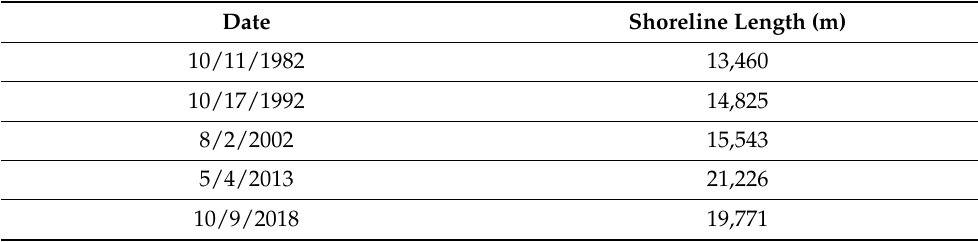
Table 8. Shoreline length data of segment E.